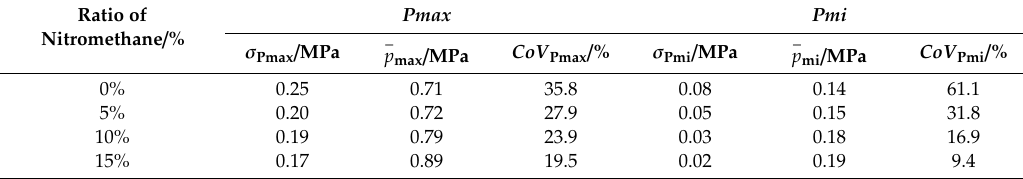
Table 6. Combustion cyclic variations of methanol-nitromethane